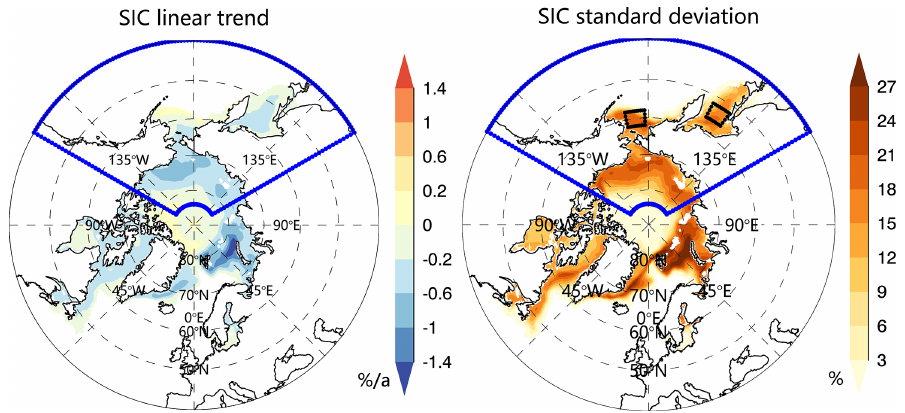
Figure 1. Arctic SIC trends (left) and standard deviation (right) computed using SIC anomalies over all 12 months of the period 1979–2020. The Pacific-Arctic model domain is enclosed by blue lines, which covers 40–84 ◦ N and 120–240 ◦ E. Two focused areas marked in black boxes in the Bering Sea (58–62 ◦ N and 182–192 ◦ E) and the Sea of Okhotsk (52–56 ◦ N and 144–152 ◦ E) have large standard deviations and are selected to evaluate the ACC skill improvement in the regional model compared with the pan-Arctic Markov model developed by Yuan et al. (2016).